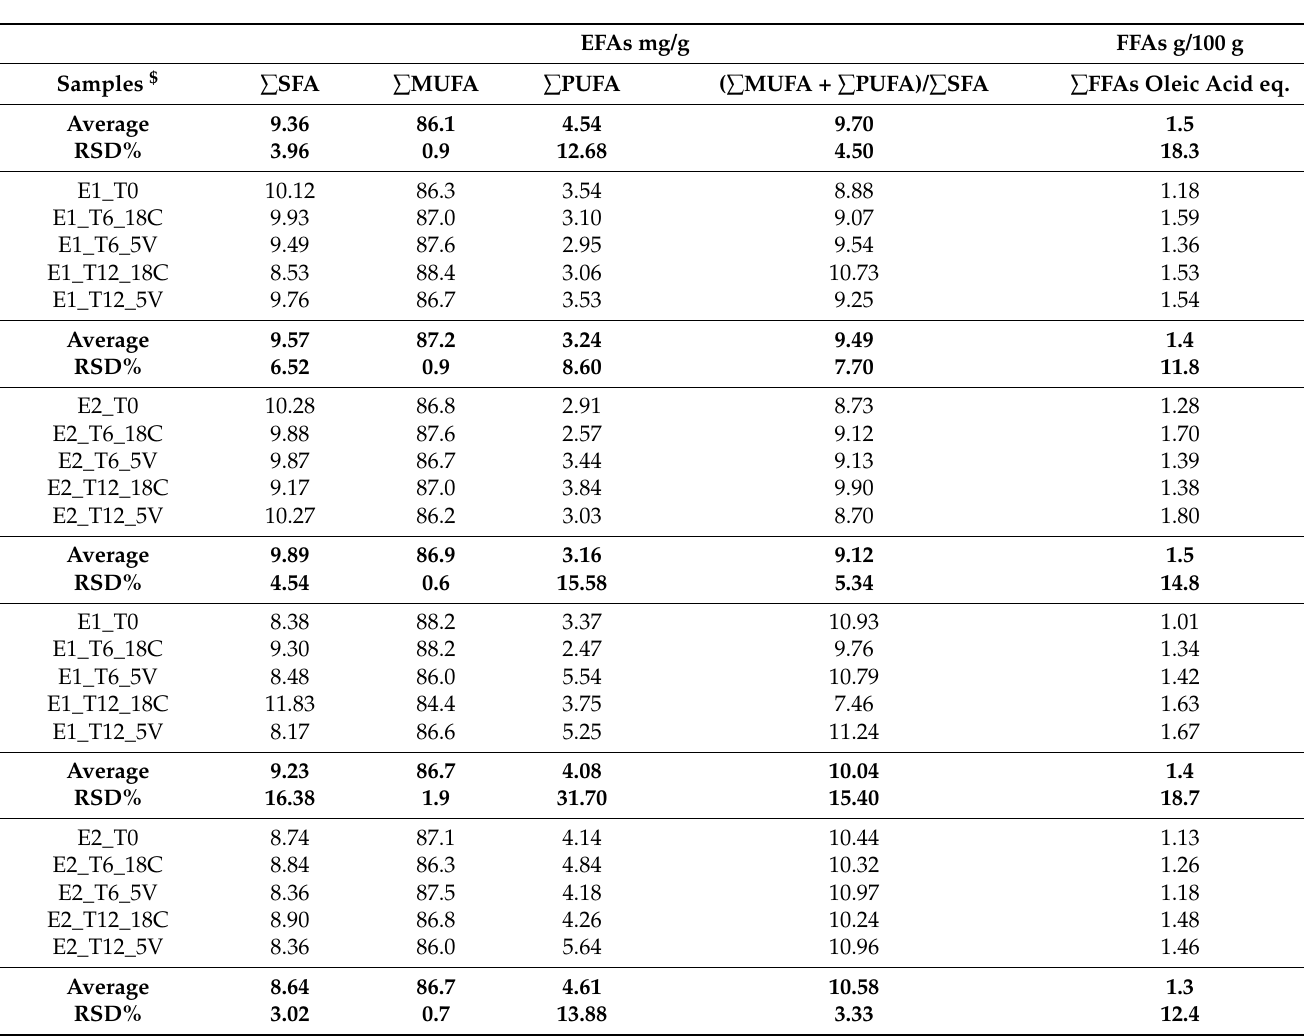
$ Samples acronym are clarified in Table